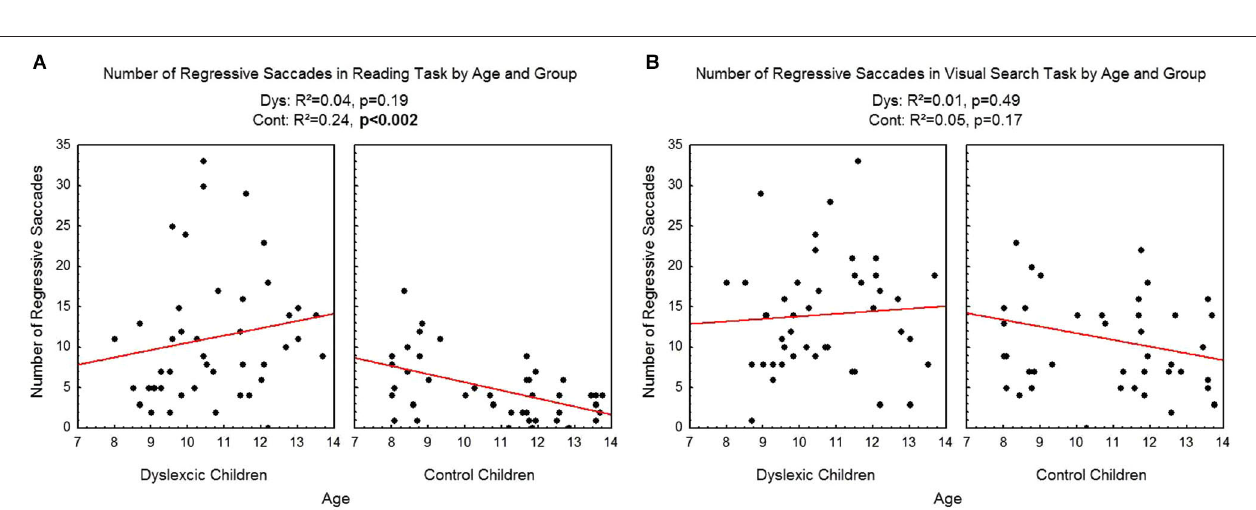
FIGURE 6 | Number of regressive saccades during reading (A) and visual search (B) for the both groups of subjects . Lines represent the corresponding regressions.